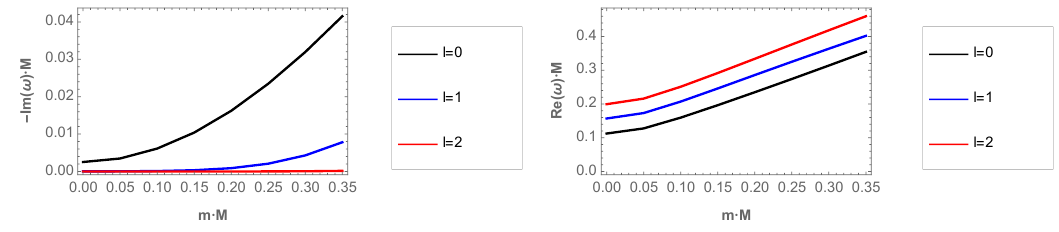
Figure 6 . The behaviour of fundamental mode (cid:0) Im ( ! ) M (left (cid:12)gure) and Re ( ! ) M (right (cid:12)gure) as a function of mM for di(cid:11)erent values of the parameter ‘ = 0 ; 1 ; 2, with M 2 (cid:3) = (cid:0) 0 :